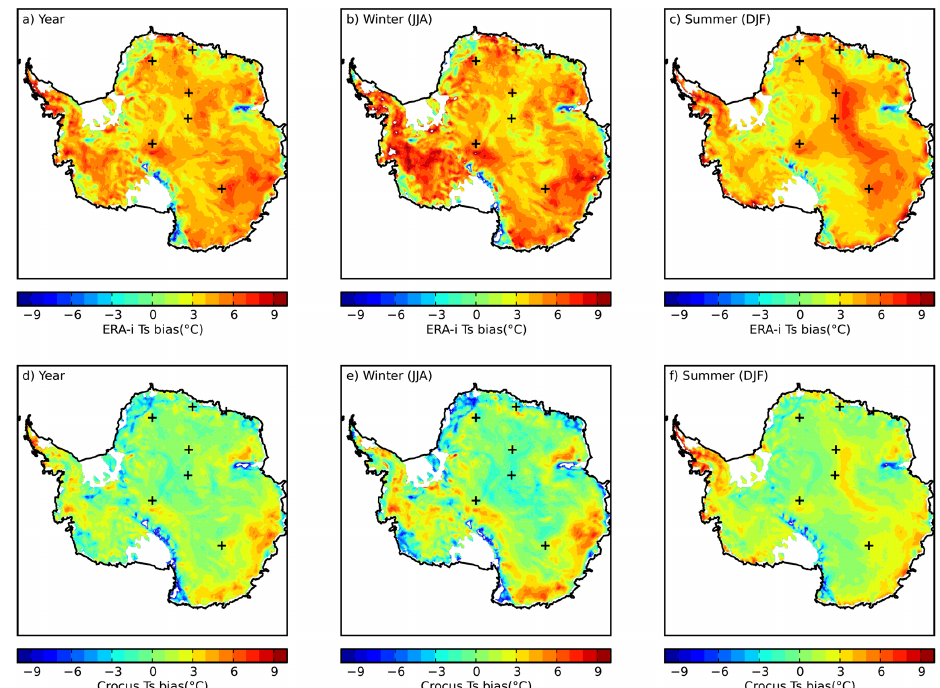
Figure 3. (a) 2000–2011 averaged ERA-i T s bias, (b) ERA-i T s bias in winter (JJA) and (c) ERA-i T s bias in summer (DJF), with respect to MODIS T s . (d) 2000–2011 averaged Crocus T s bias, (e) Crocus T s bias in winter (JJA) and (f) Crocus T s bias in summer (DJF), with respect to MODIS T s